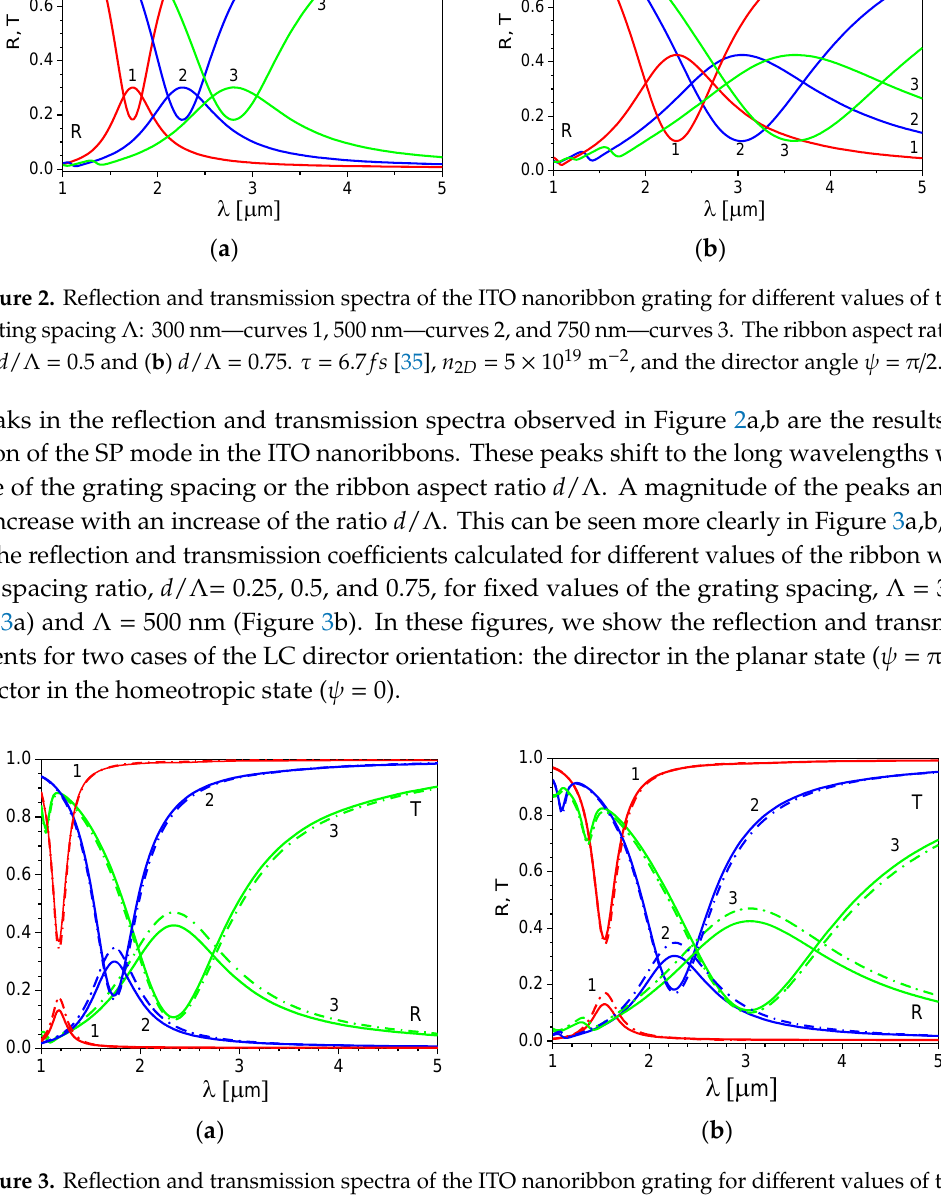
n = 5 × 10 19 m −2 . 149 2 D